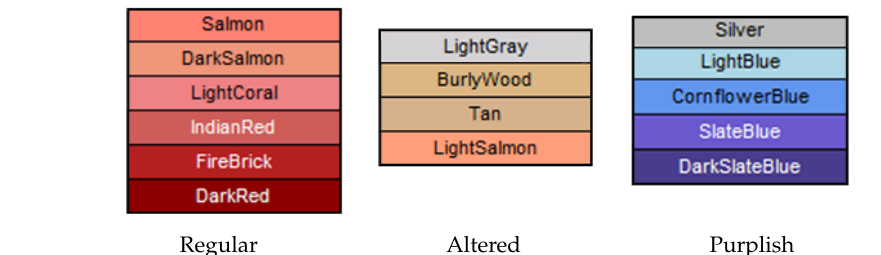
Figure 6. Categories for the color of